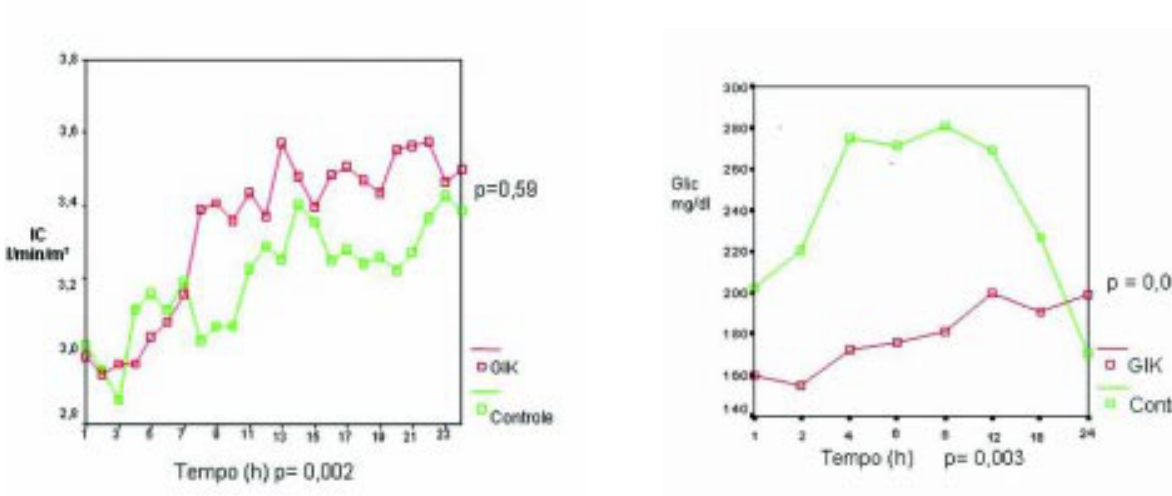
Fig. 2 - Médias das Glicemias - Gráfico ilustrando as médias das glicemias nos grupos GIK e de Controle nas 24